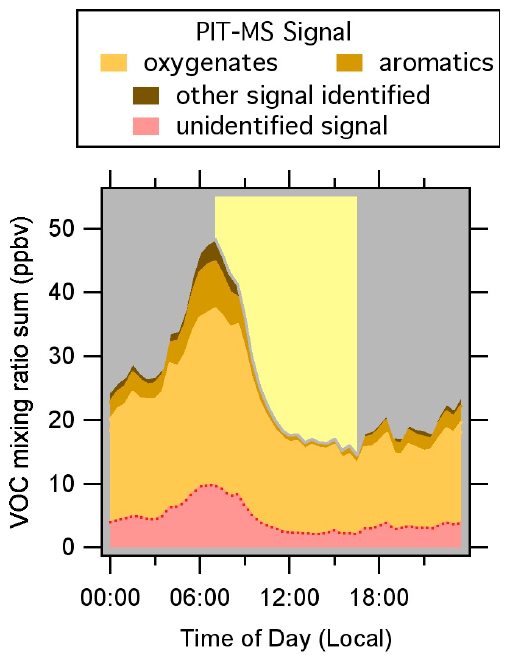
Figure 6. Average fraction of total PIT-MS signal attributed to oxygenates, aromatics and other identified signal during the MILAGRO campaign. Unidentified signal averages about 18% of the total.